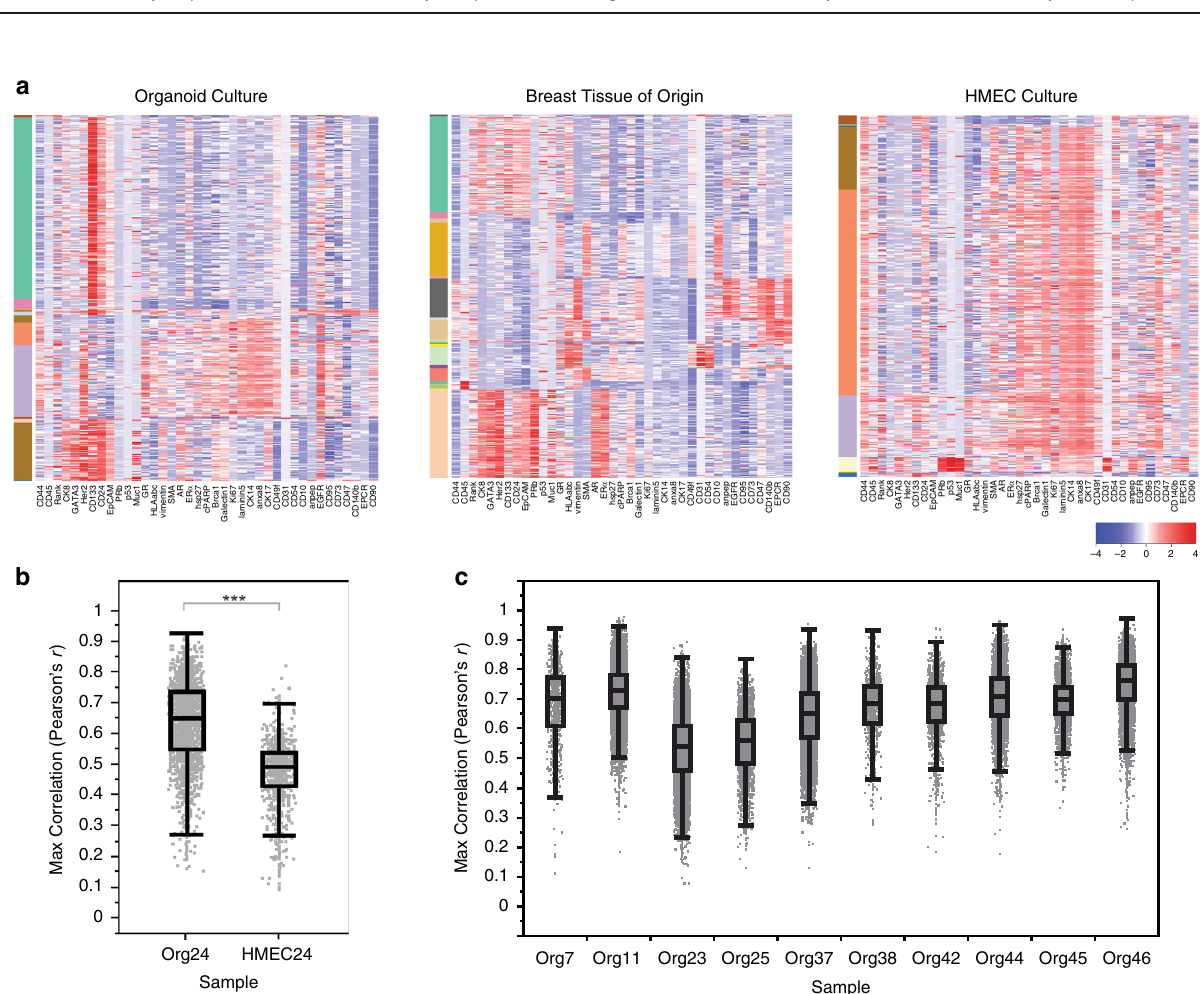
Fig. 4 Complex mammary-speci fi c protein expression patterns from the tissue of origin are maintained in culture. Four normal mammary tissues were digested to single cells and fi xed with paraformaldehyde. In parallel, organoid cultures were generated from each of the tissues, passaged four times, digested to single cells, and fi xed. Protein expression levels of 38 markers associated with mammary tumorigenesis and development were analyzed at the single-cell level in the organoid cultures and the matched tissues of origin using cytometry by time of fl ight (CyTOF). a Force-directed layout of organoid cultures and matched tissues of origin, where each dot represents one cell, and the closeness in space is related to their similarity in terms of protein expression patterns. Cells are colored by X-shift-de fi ned clusters. b Delineation of the major mammary populations on the force-directed layout based on expression of standard protein markers for these cell types. c Examples of lineage-speci fi c markers used to determine the mammary populations shown in b , including luminal (CK8 and EpCAM), mature luminal (GATA3), and basal/stem (CK14, SMA, and CD49f), as well as stromal markers (CD31, CD45, and CD140b) (warmer colors = higher expression levels). d For comparison, a normal mammary tissue was digested to single cells and fi xed, and in parallel a two-dimensional culture of human mammary epithelial cells (HMECs, cultured in Lonza MEGM) was generated and passaged two times. HMECs and the matching tissue of origin were also analyzed using CyTOF as in a . The experimental schematic, delineation of cell types on force-directed layout, and cells from the tissue or cells from the culture are highlighted in the different panels for both the organoids (left column) and the HMECs (right column). e Correlation between the protein expression pro fi les of each HMEC or organoid cell and expression signatures derived from the major epithelial clusters in matched primary tissue. Box plots (center line, median; box limits, upper and lower quartiles; whiskers, 1.5× interquartile range) show the maximum r value of each cell to the major epithelial clusters, strati fi ed by sample. Statistical signi fi cance was assessed by two-sided Mann – Whitney test (*** p < 2.2e − 16).